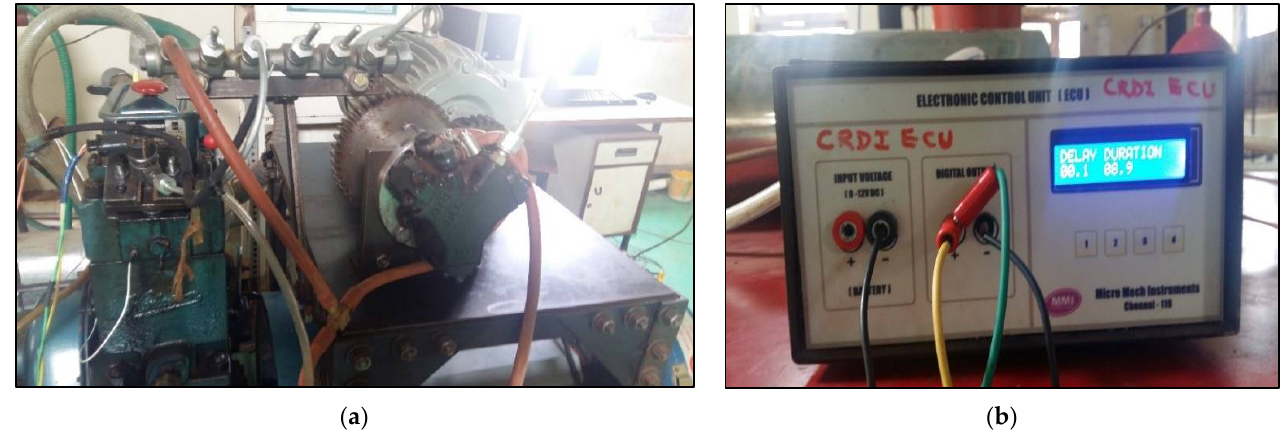
Figure 4. ( a ) CRDI system integrated CI engine; ( b ) ECU facilitated CRDI injectors [42] .